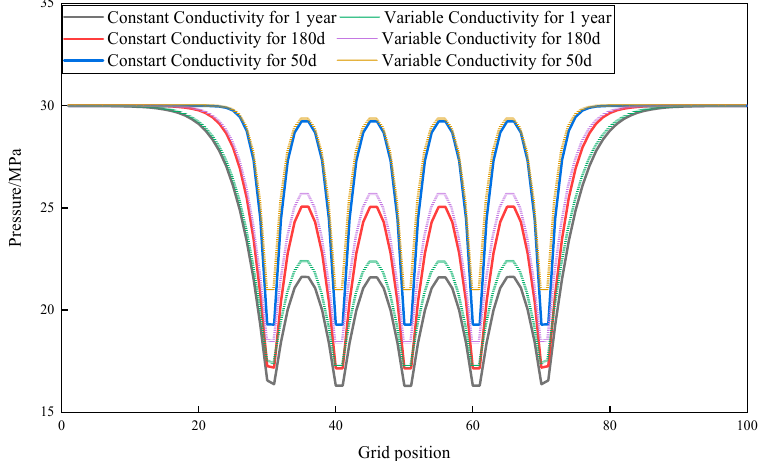
Figure 7. Pressure distribution near wellbore.